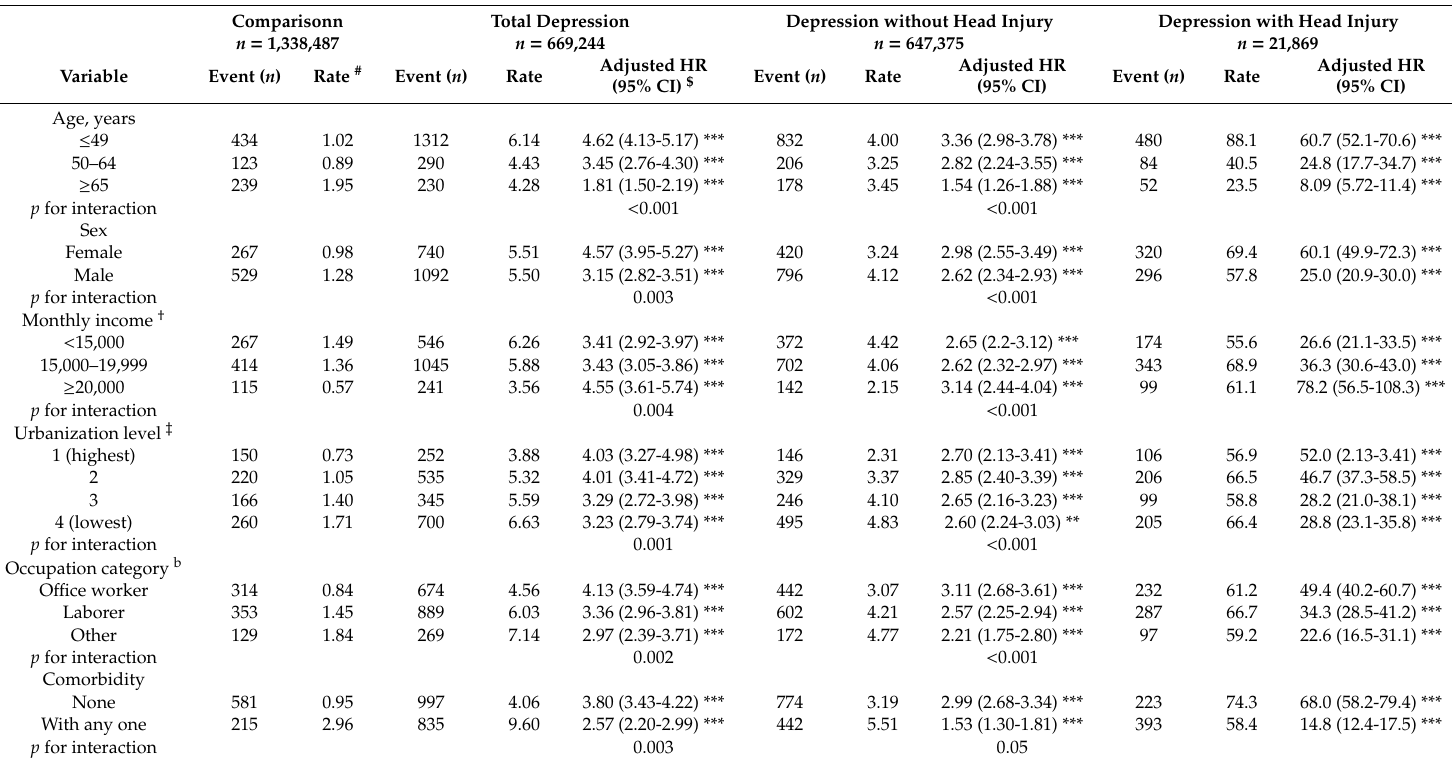
Table 3. Comparison of hazard ratios for suicide attempt stratified by age, sex, and comorbidity between the depression and comparison cohorts. Comparisonn n =